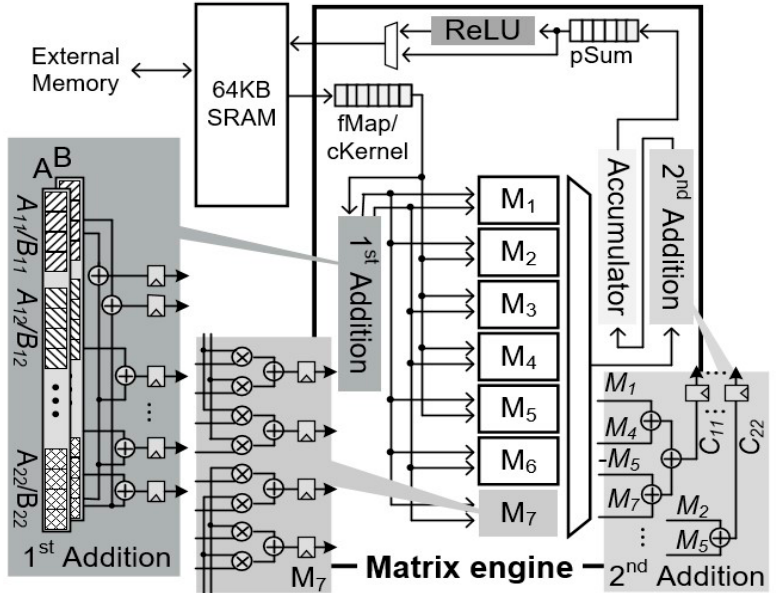
Figure 6. Cost-effective neural network accelerator (CENNA) architecture. Figure 6. Cost-e ff ective neural network accelerator (CENNA)